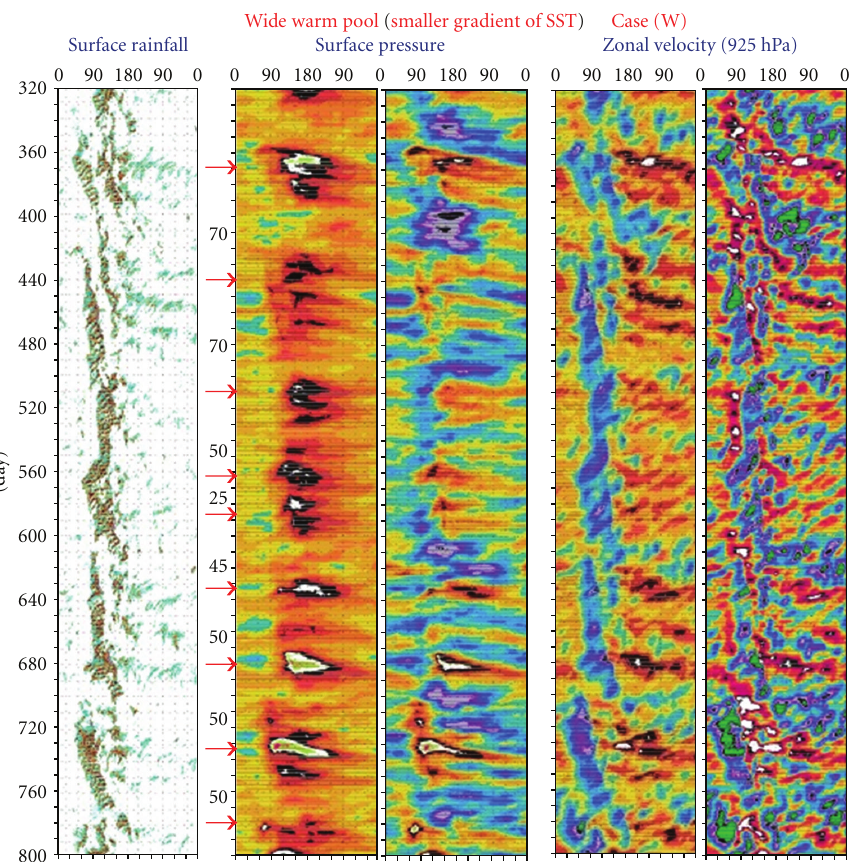
Figure 5: Same as Figure 2 but for case